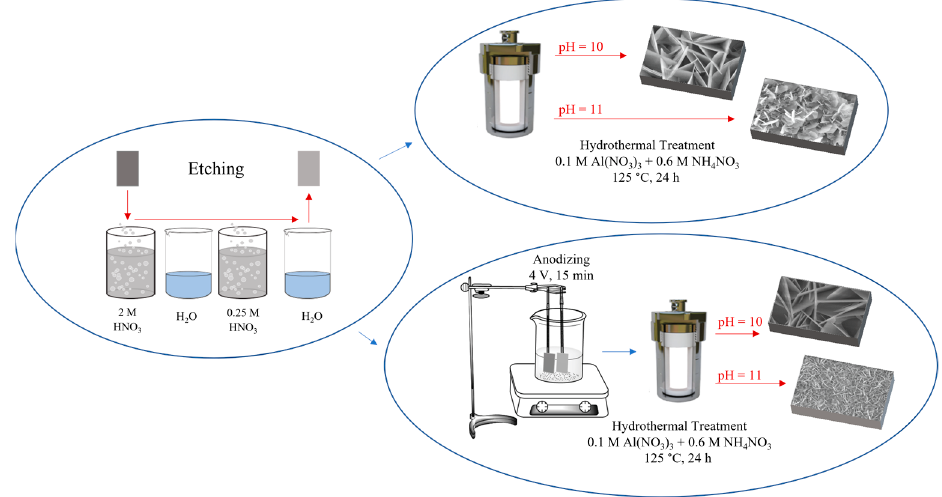
Figure 1 . Schematic image of LDH production. Figure 1. Schematic image of LDH production. Table 2. Codes used for samples with epoxy